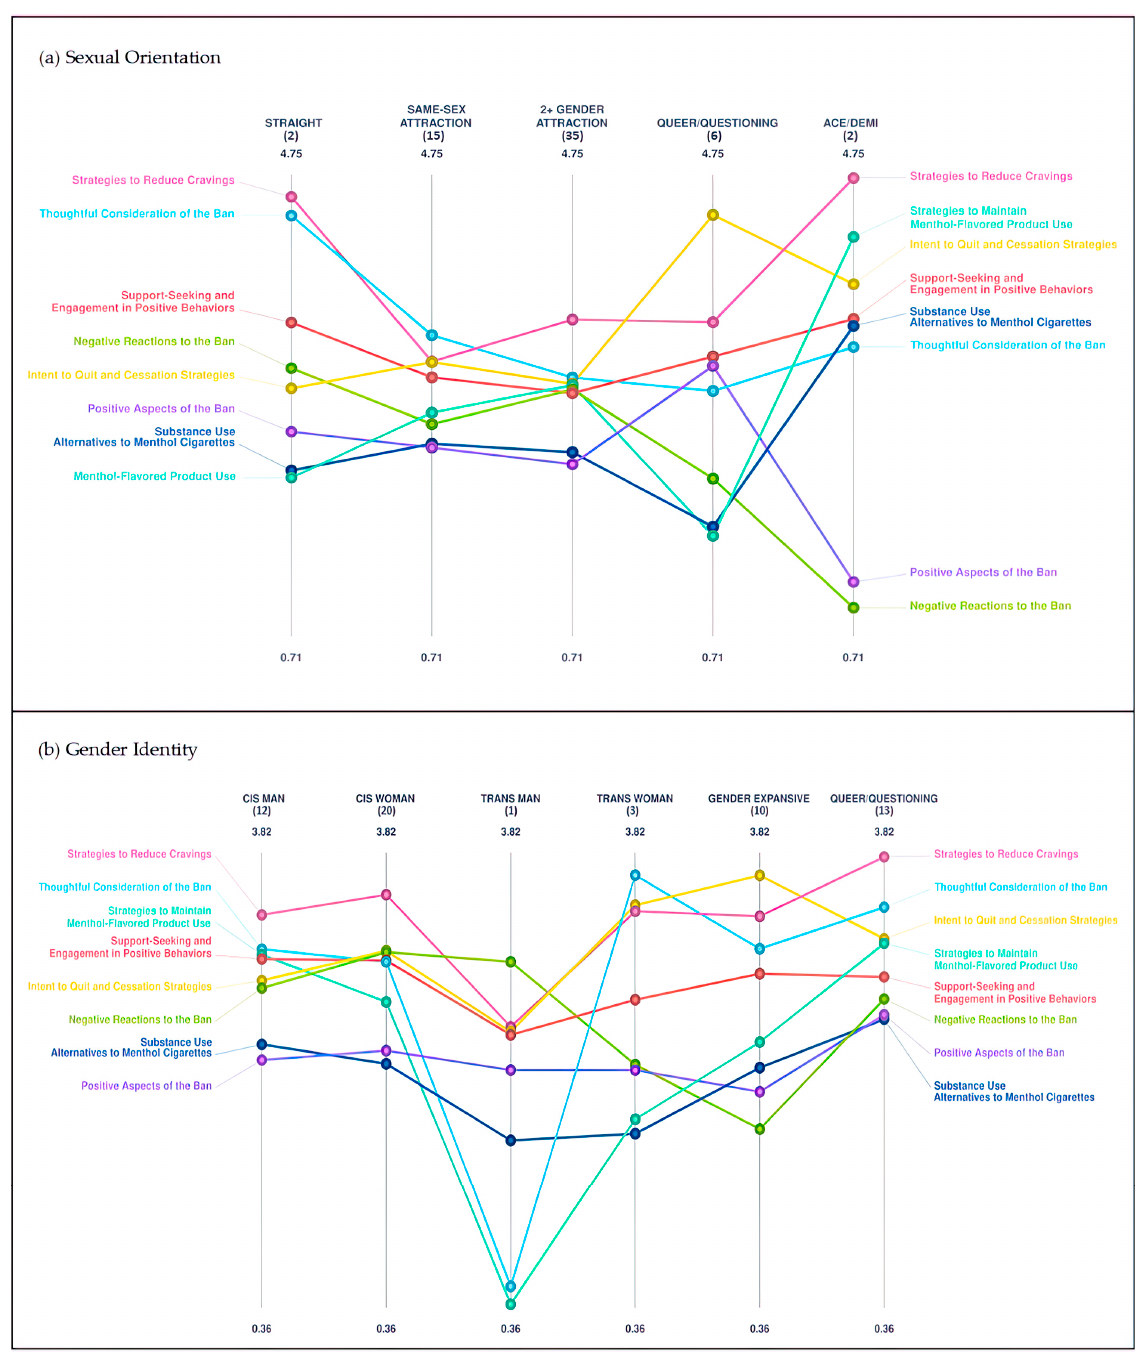
Figure 3. ( a , b ) Pattern-matching results comparing cluster rating averages for multi-level SGM var- iables: ( a ) sexual orientation; ( b ) gender identity. Numbers in parentheses represent subgroup sam- ple sizes.